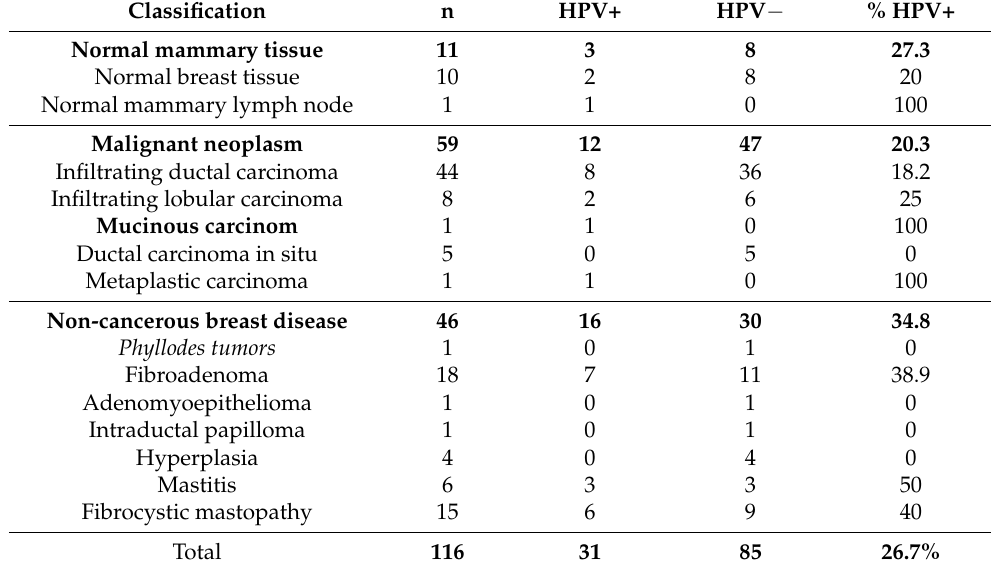
Table 3. Histopathological classification according to World Health